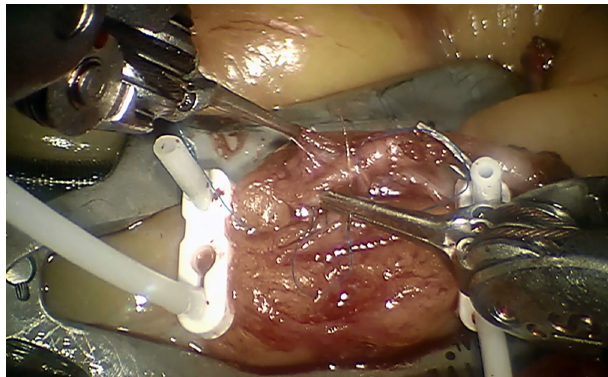
Fig. 3 - LIMA-LAD anastomosis half way